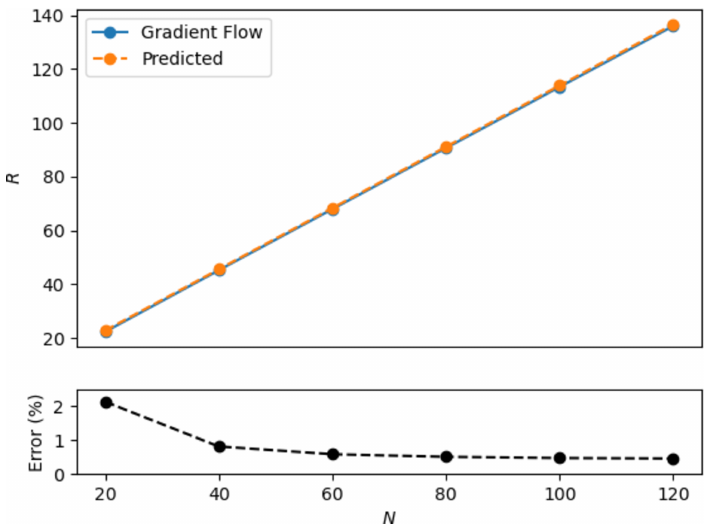
Figure 11 . A comparison of the predicted radii from the TSA to the radii of solutions found via gradient flow with model parameters η with Q/N = 31 . 89 kept